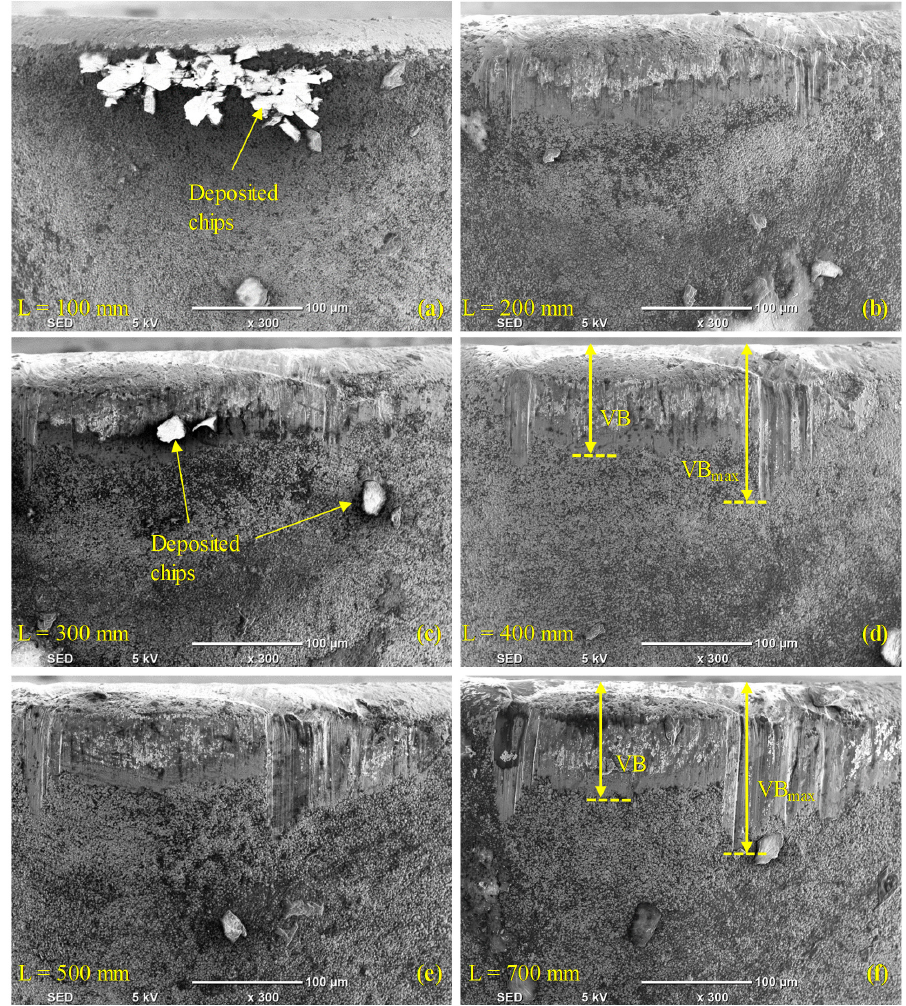
Figure 4. Flank wear in case of wiper inserts after ( a ) L = 100 mm, ( b ) L = 200 mm, ( c ) L = 300 mm, ( d ) L = 400 mm, ( e ) L = 500 mm, and ( f ) L = 700 mm.